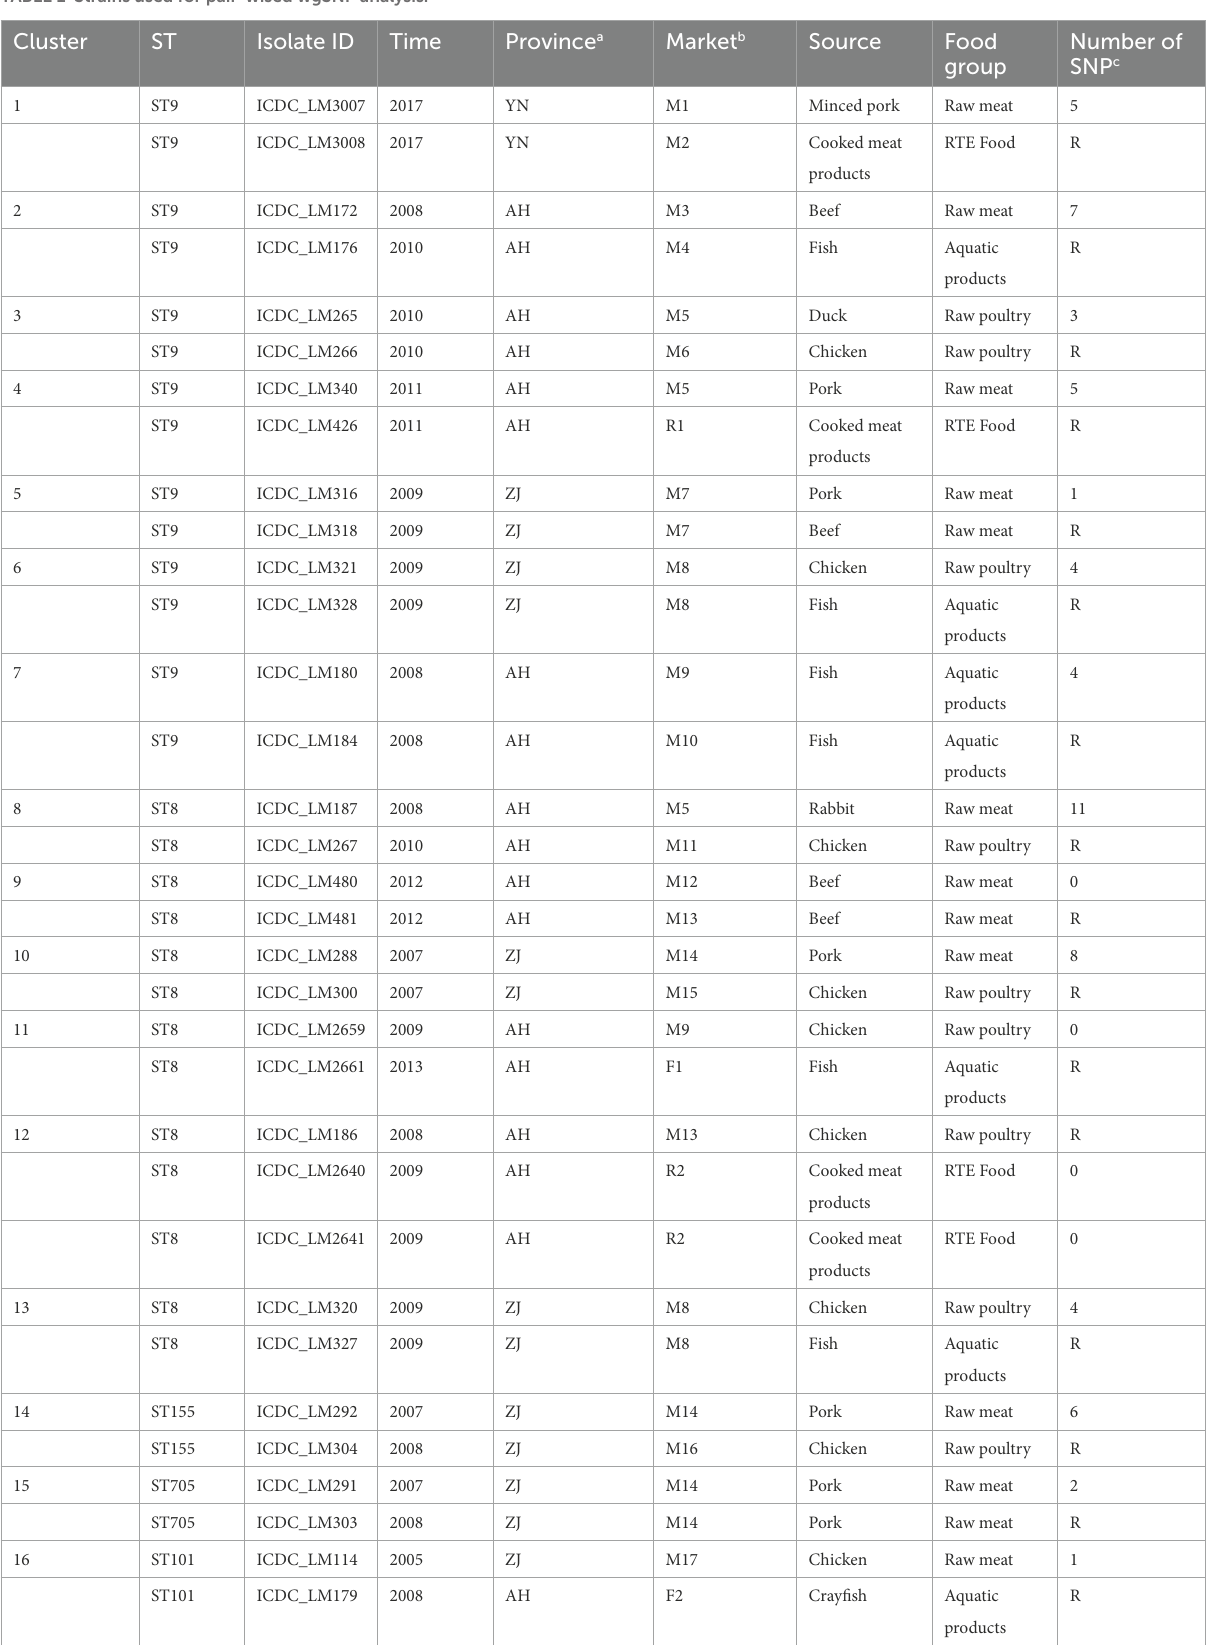
TABLE 1 Strains used for pair-wised wgSNP